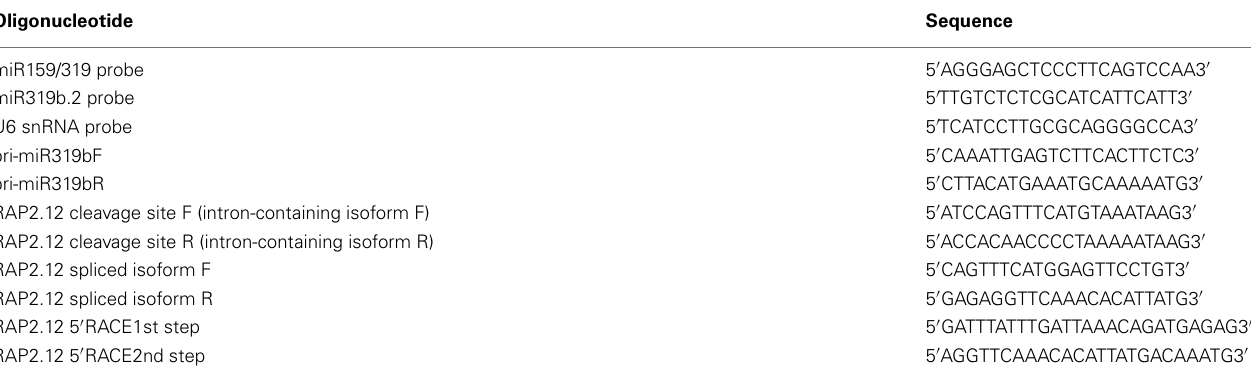
TableA1 | Olioguncleotide sequences used as primers or probes. Oligonucleotide